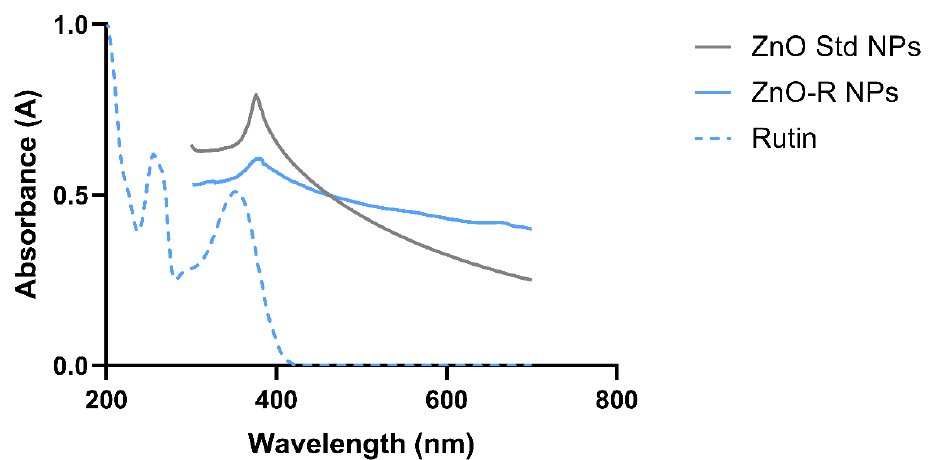
Figure 5. UV-Vis absorption spectra of ZnO Std NPs, ZnO-R NPs and rutin.